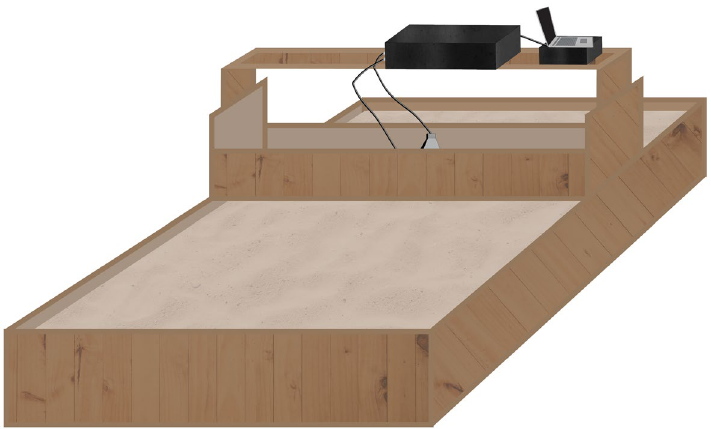
Figure 14. Illustration of the GPR configuration utilized for generating experimental training and testing data used by the proposed surrogate-assisted buried object characterization